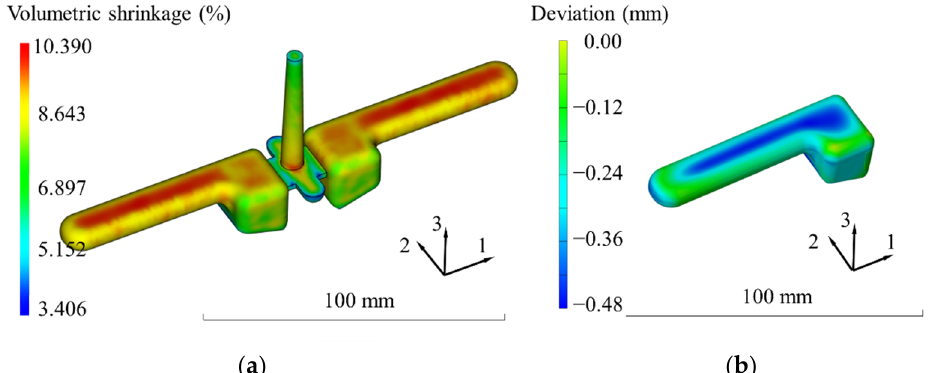
Figure 4. The simulated volumetric shrinkage ( a ) and the deviation between injected door handle and mould cavity according to GOM measurements ( b ).